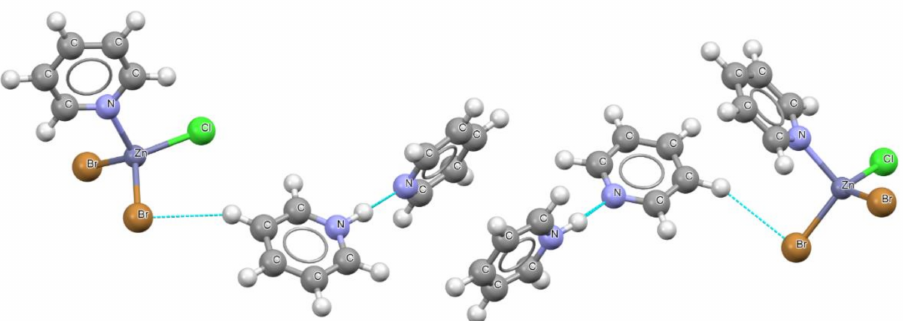
Figure 5. The fragment of the crystal structure of pyridinium dibromo-chloro-pyridine-zinc(ii) pyridine solvate, PYCBZN01 refcode, reference